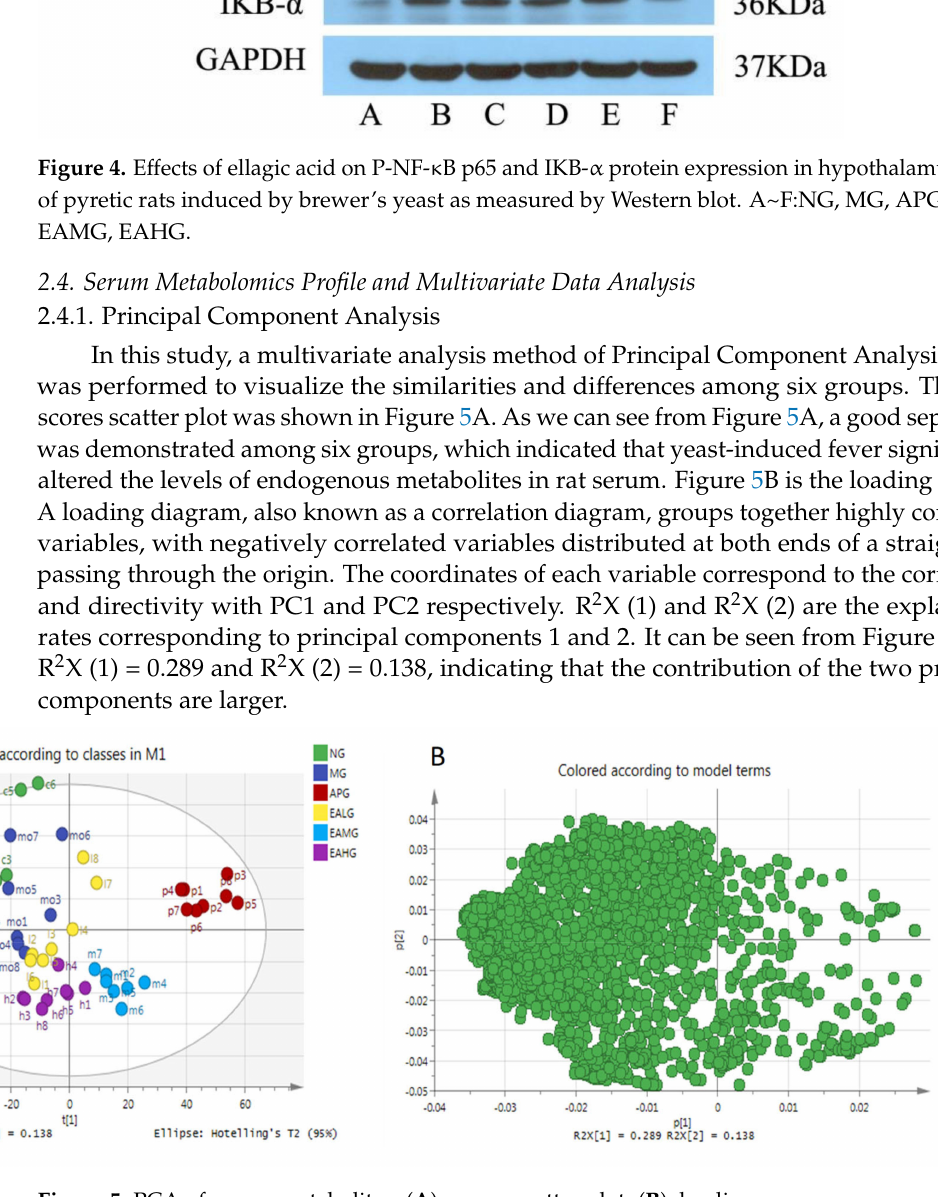
Figure 5. PCA of serum metabolites. ( A ): scores scatter plot. ( B ):